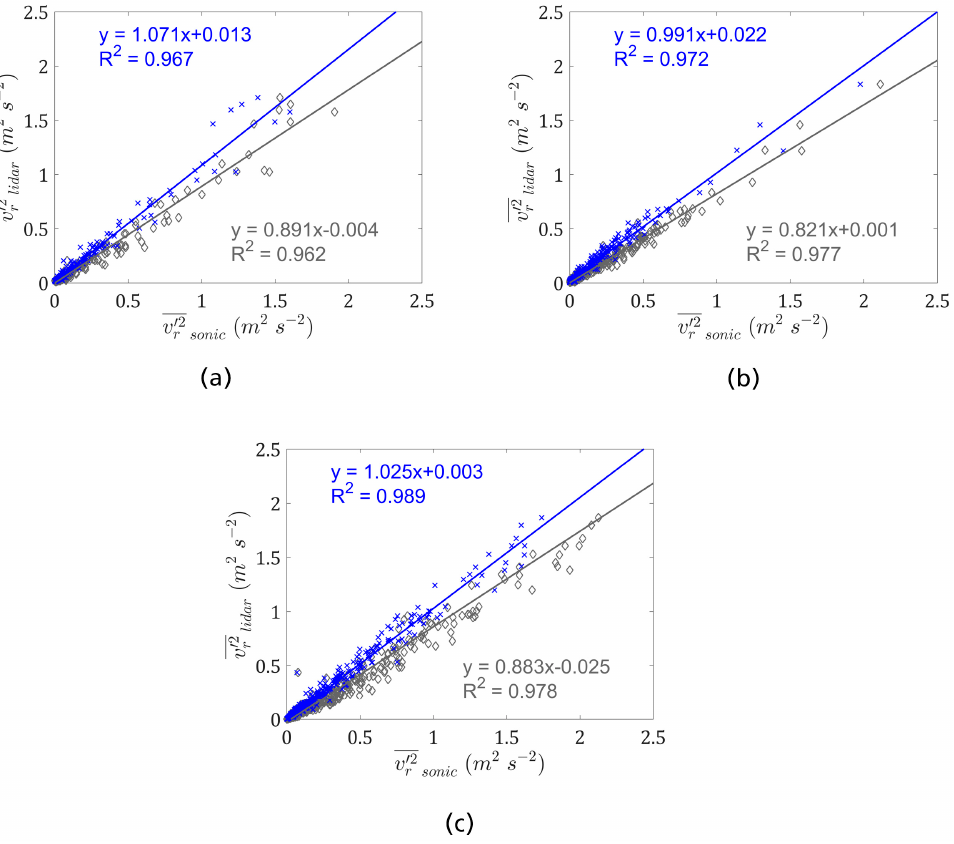
(cid:3364)(cid:3364)(cid:3364)(cid:3364)(cid:3364) (cid:4673) against the (cid:3039)(cid:3036)(cid:3031)(cid:3028)(cid:3045) (cid:3364)(cid:3364)(cid:3364)(cid:3364)(cid:3364) (cid:4673) when (cid:3046)(cid:3042)(cid:3041)(cid:3036)(cid:3030) (cid:2870) to separate out the effects of the